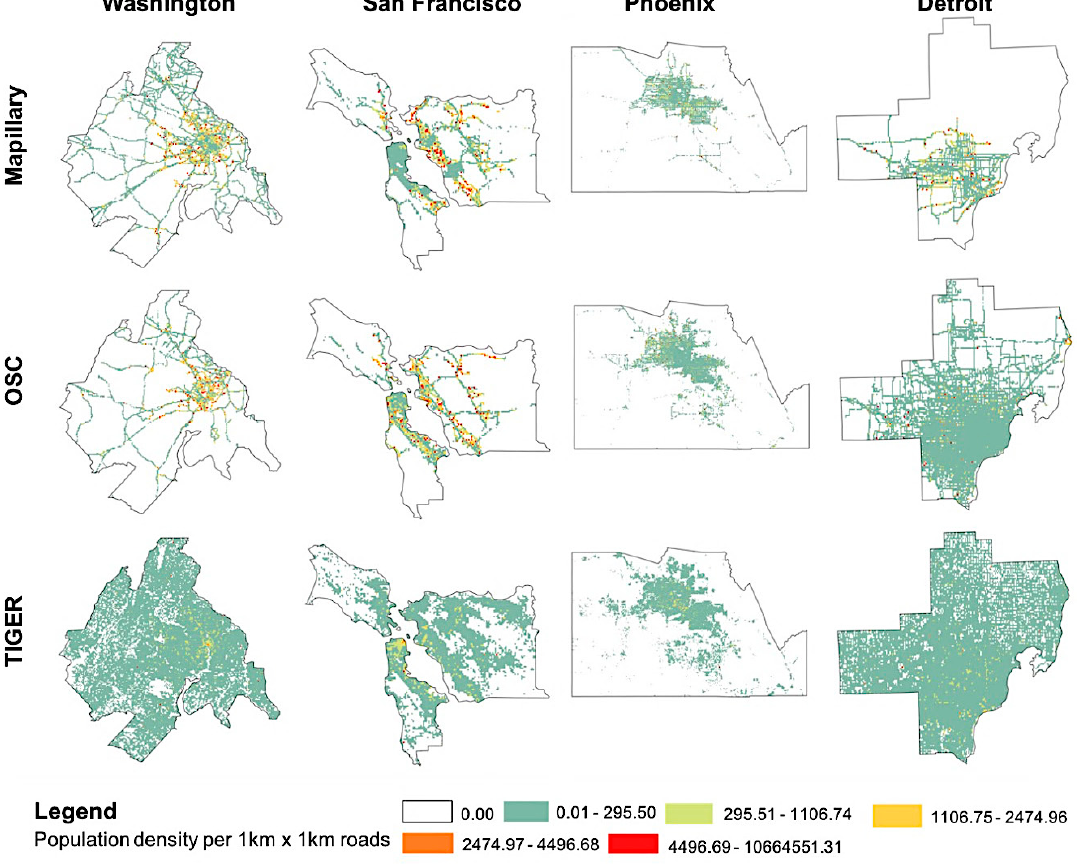
Figure 5. Normalized population density per 1 × 1 km road